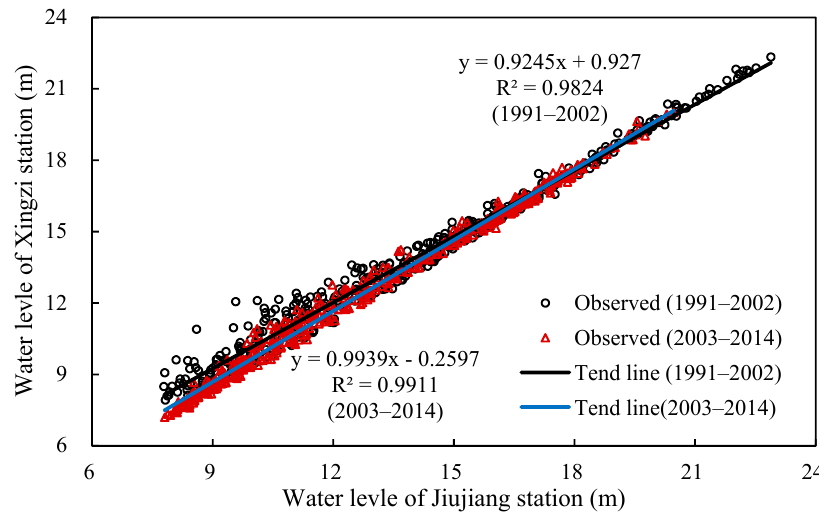
Figure 8. Relationship between the 10 day water level measured at Xiangzi Station and Jiujiang Station.